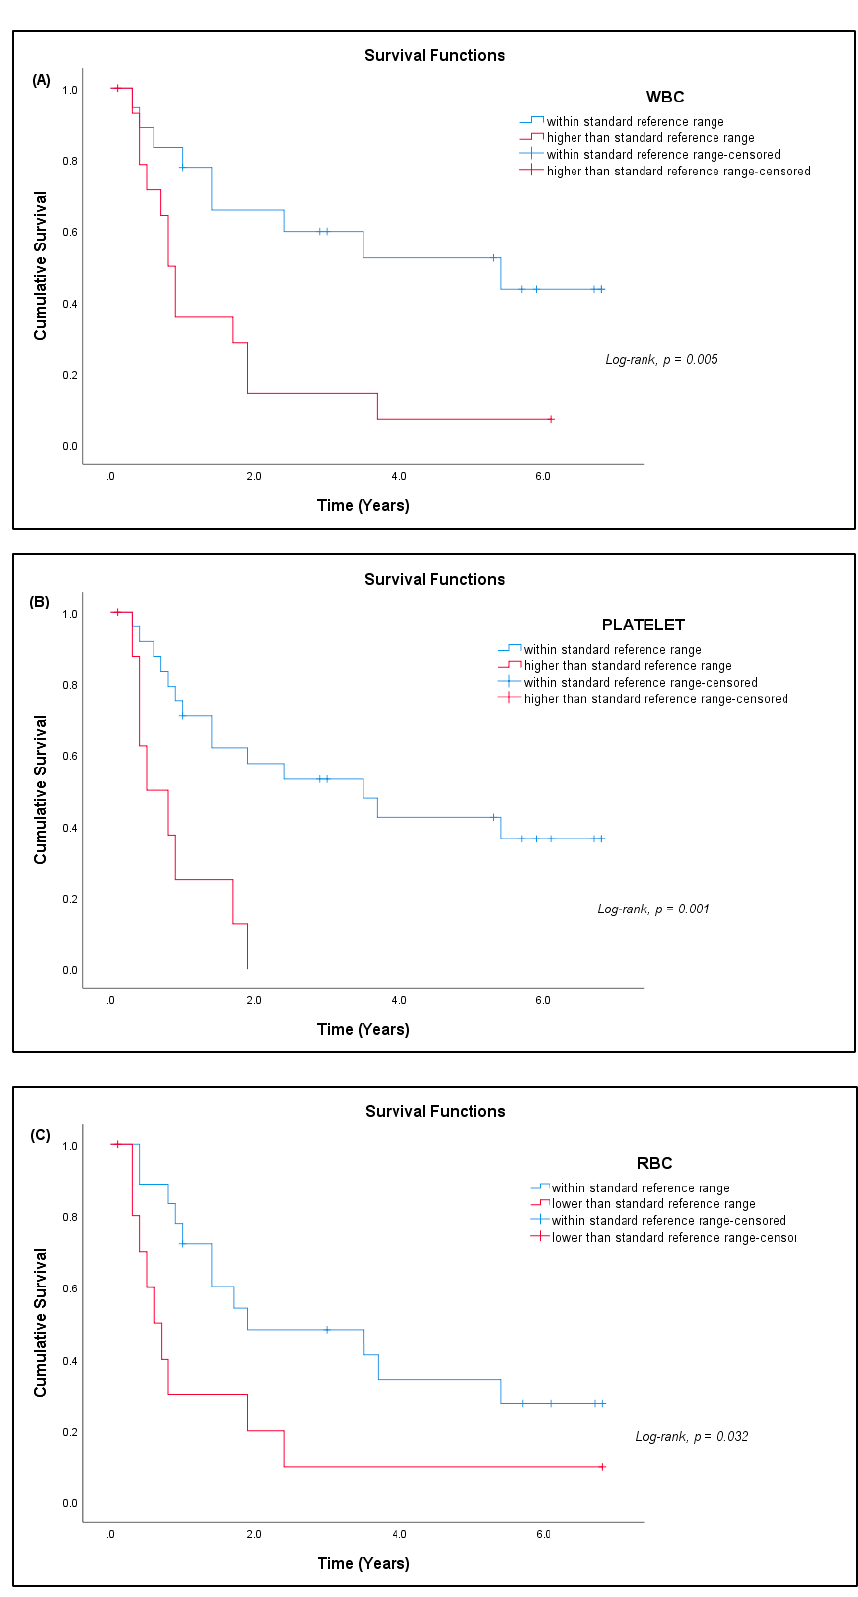
Figure 5. Kaplan–Meier curve for overall survival. ( A ) All sarcoma patients, ( B ) disease-specific sar- coma patients, and ( C ) patients tested for CD4 + T-cell/lymphocyte percentage.